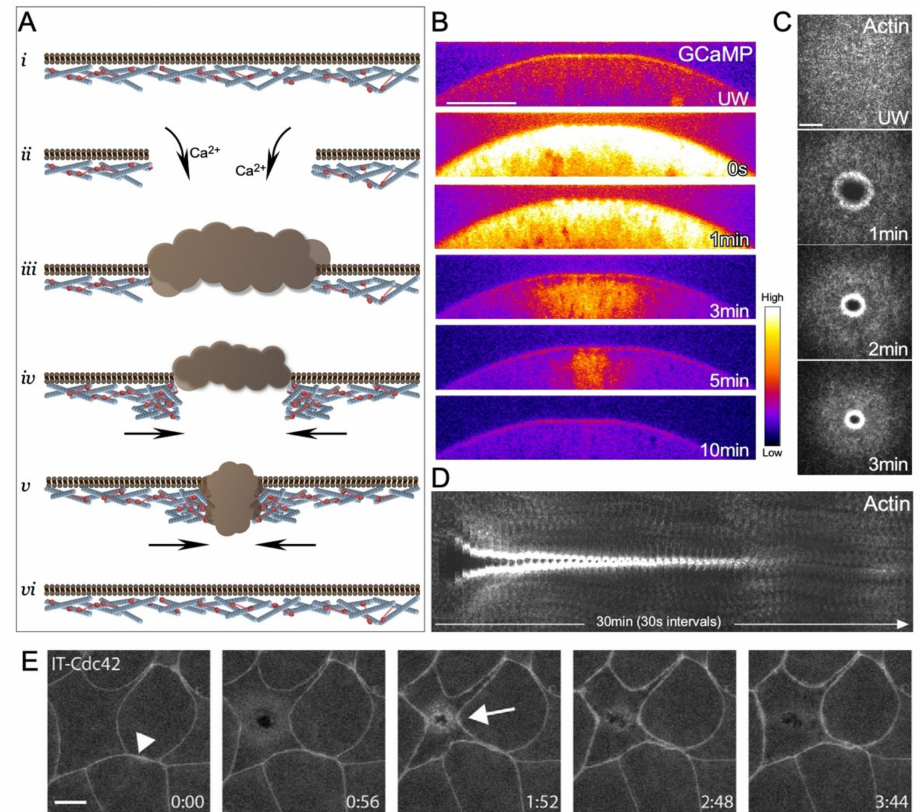
Figure 1. Aspects of single cell wound repair in model organisms. ( A ) Schematic of the major steps in cell wound repair: ( i ) unwounded plasma membrane and actin cytoskeleton; ( ii ) initial influx of calcium ions initiating the wound repair process; ( iii ) temporary vesicular membrane patch formed to quickly plug the injury site; ( iv ) formation of an actomyosin ring in the cortical cytoskeleton around the injury site; ( v ) translocation of the actomyosin ring to pull the wound closed; ( vi ) remodeling of the cell cortex to remove the temporary membrane patch and the actomyosin ring, and to restore homeostasis. ( B ) Confocal micrographs of cross-section of a syncytial Drosophila embryo expressing a calcium reporter (GCaMP) during the wound repair process. Scale bar: 20 µ m. ( C ) XY maximum confocal micrographs of the actin ring formed post laser injury in a syncytial Drosophila embryo. Scale bar: 20 µ m. ( D ) XY kymograph across the wound area depicted in ( C ). During the wound repair process, a robust actin ring forms around the wound, translocates inward to reduce the wound area and eventually disassembles when the wound is closed. ( E ) Example of a single cell wound within the context of the epithelia of a Xenopus embryo showing the accumulation of a Cdc42 reporter at the wound periphery (arrow) and at cell-cell junctions (arrowhead). Scale bar: 10 µ m. Reprinted from Golding et al., (2019), eLife 8: doi:10.7554/eLife.50471